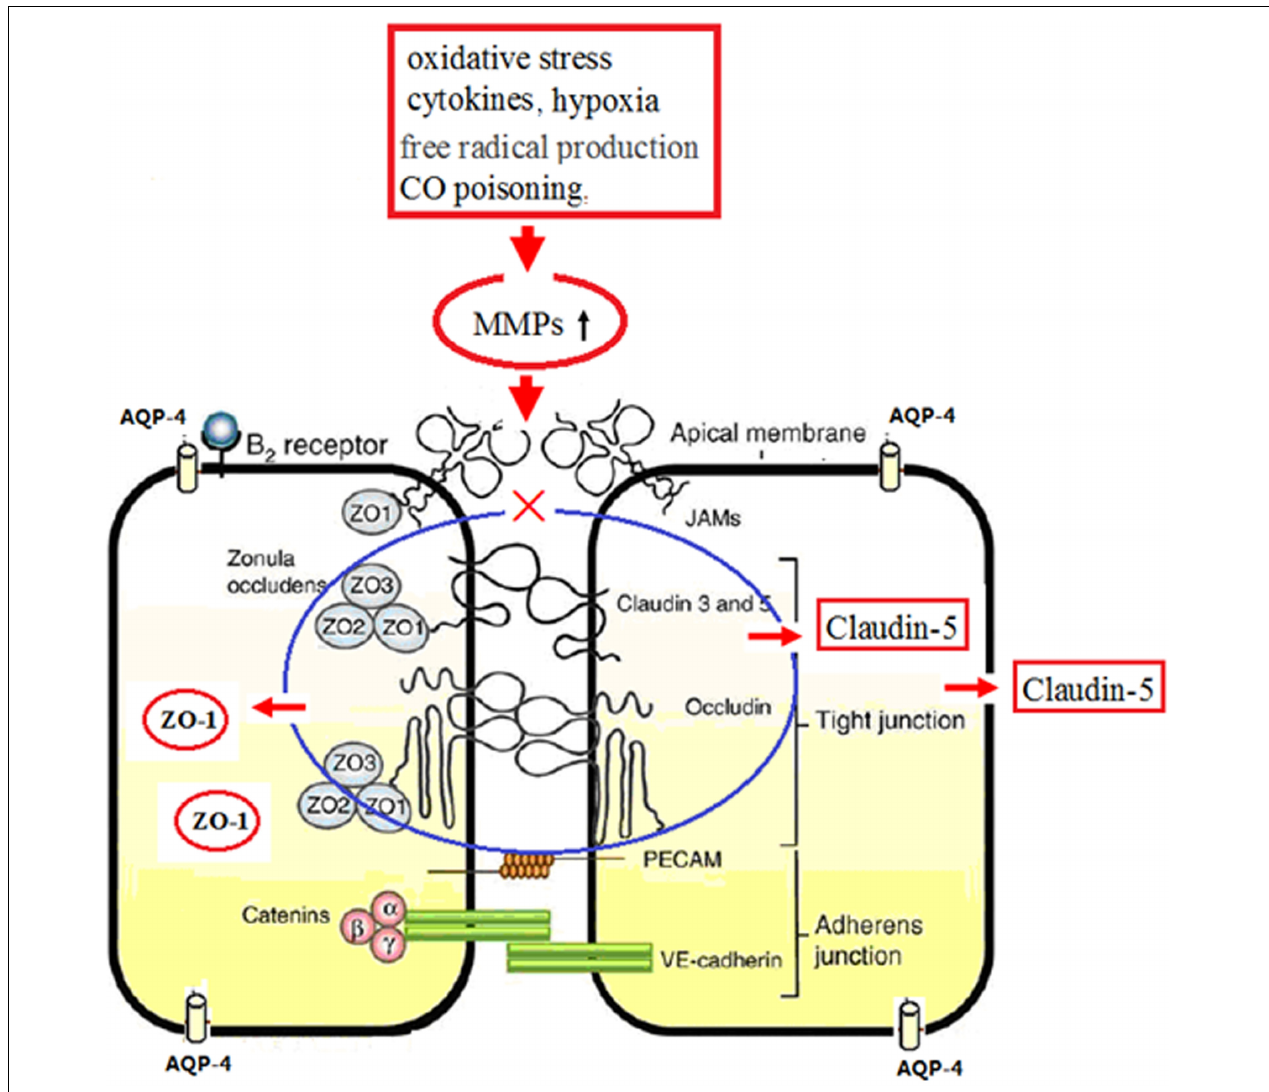
FIGURE 11 | Schematic diagram of ZO-1, claudin 5, and AQP-4 in continuous endothelium and the molecular mechanism after CO poisoning. Physiologically, tight junction complexes (including ZO-1, occludin, and claudin-5 proteins) anchor in the transmembrane proteins of endothelial cells (blue mark). Under the pathological circumstances, such as oxidative stress, free radicals, CO poisoning, hypoxia and inflammation, neutrophils, and lymphocytes will induce the over-production and the activation of MMPs, which subsequently accelerate the lysis of TJ complexes and the degradation and translocation of ZO-1 and claudin-5 proteins, resulting in the impairment of BBB (red